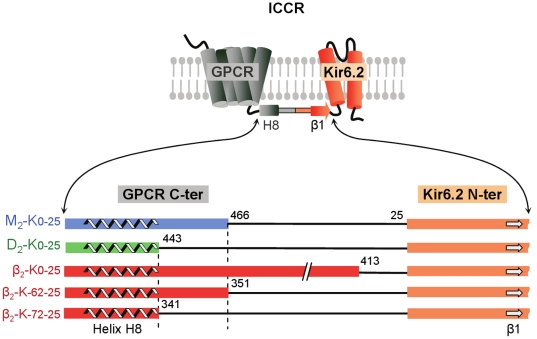
Design strategy of β2-based Ion Channel-Coupled Receptors.ICCRs were formed by covalent linkage of GPCRs C-termini to Kir6.2 channel N-terminus. Helix H8 and β-bridge β1 are predicted from the β2AR (PDB code: 2RH1) and chimeric Kir3.1 (PDB code: 2QKS) structures, respectively. M2-K0–25 and D2-K0–25 are the ICCRs previously shown to be functional with 25 residues deleted from the Kir6.2 N-terminus. We used the same Kir6.2 deletion to build β2 ICCRs, with additional deletions in the receptor C-terminus. β2-K0–25 ICCR contains the full-length receptor, β2-K-62-25 and β2-K-72-25 are based on the β2AR deleted of 62 and 72 residues in its C-terminal domain to match the lengths of M2 and D2, respectively.